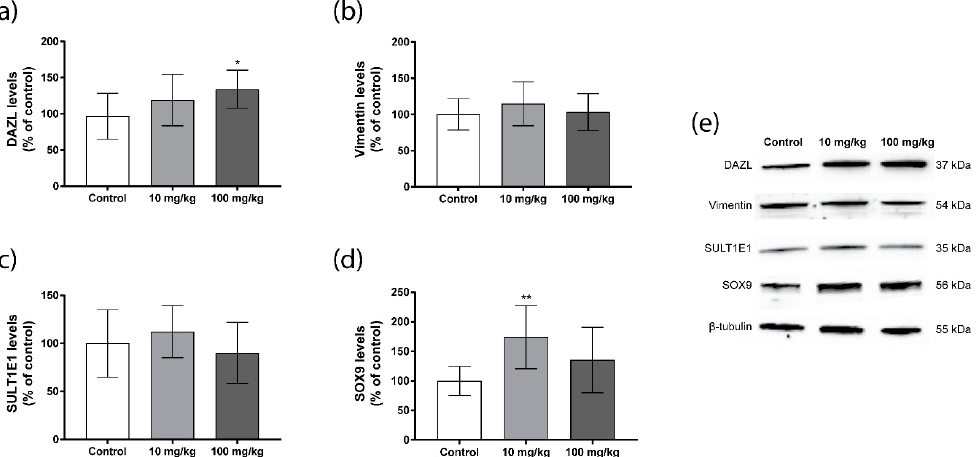
Figure 7. Persistent effects of five weeks oral DBP exposure on testicular cell markers in adult mice. Levels of DAZL ( a ), vimentin ( b ), SULT1E1 ( c ), and SOX9 ( d ) were measured by Western blot in mouse testis collected one week after the last DBP administration. Values represent mean ± S.D. from 12 animals per group. Representative blots of three experiments are shown ( e ). β -tubulin was used as a loading control. Statistically significant differences from control are indicated as follows: ** p < 0.01 and * p < 0.05 (One-way ANOVA followed by Dunnet’s test).